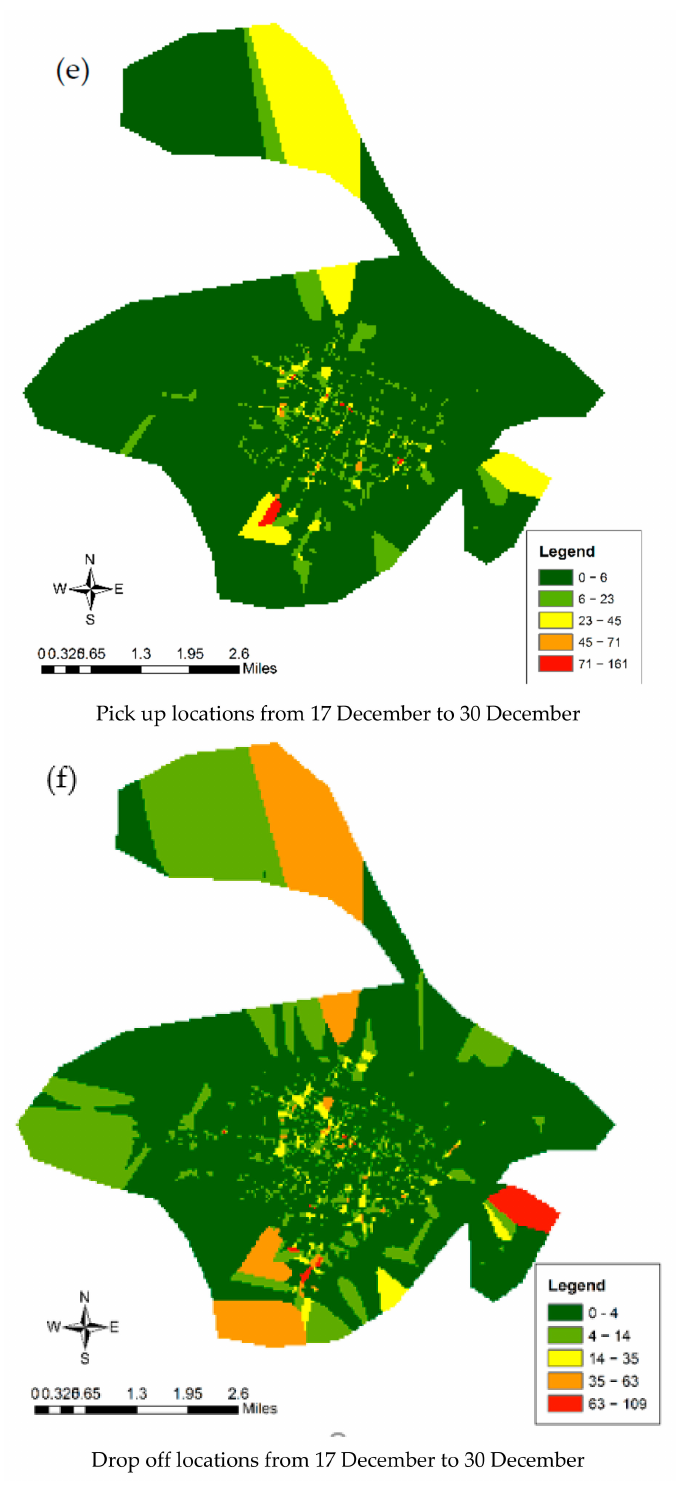
Figure 5. Spatial distribution of pick-up and drop-off locations for November and